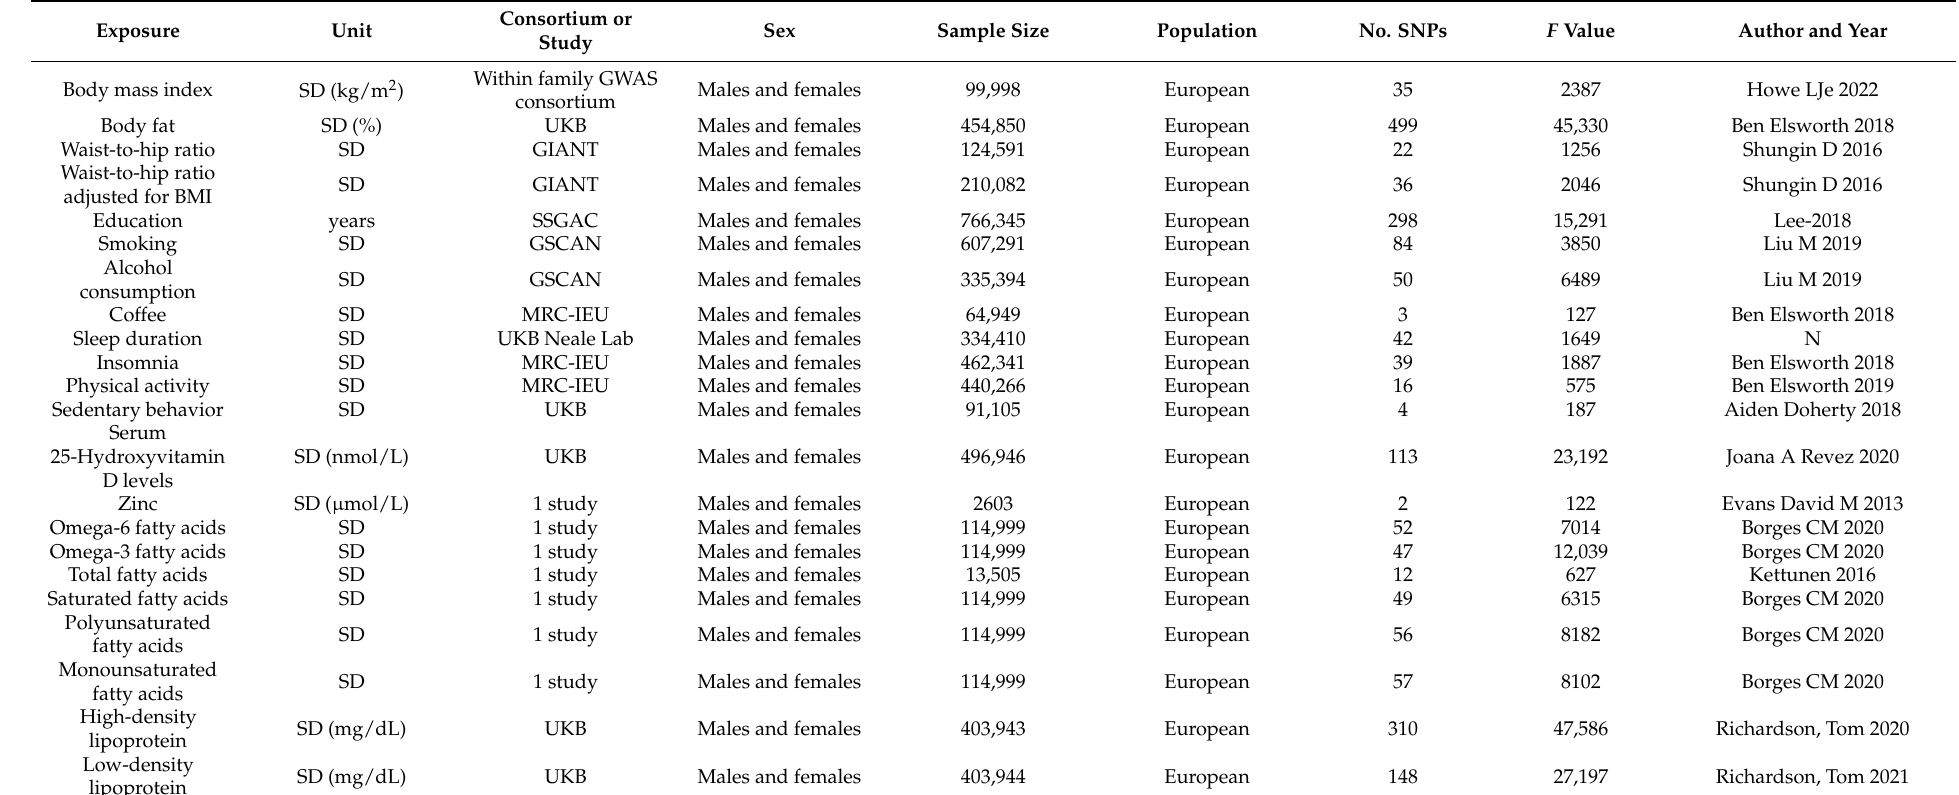
Table 2. Summary of modifiable risk